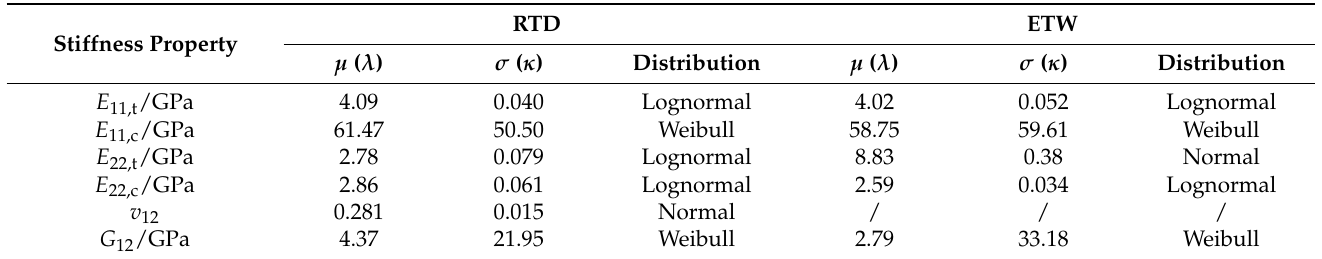
Table 11. Comparison of the probability distribution characteristics of the stiffness properties of